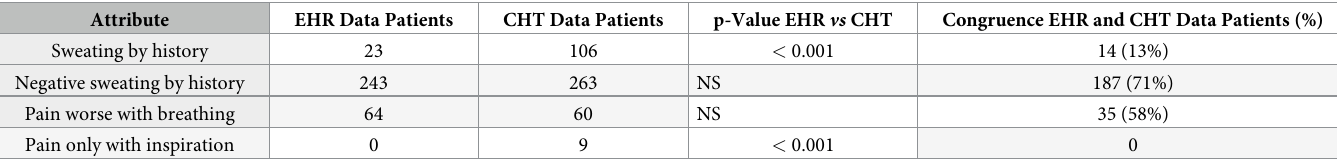
EHR data was missing for a significant proportion of patients reporting sweating during CHT; and there was poor congruence between EHRs and CHTs for explicitly positive and negative findings for sweating with chest pain (Table 6). There was no significant difference between EHR and CHT data for the number of patients with no sweating. But the lack of congruence between EHRs and CHTs for absence of sweating was signif- icant at p < 0.001. The lack of congruence between EHR and CHT data for pain exacer- bated by respiration also was significant (p < 0.001). EHRs cited that some patients had pain with breathing and others had pain with inspiration. CLEOS asked patients with a pleuritic component of pain whether pain was exacerbated by breathing or caused by inspiration and absent during breath-holding. CHT data identified 9 patients with pain relieved by breath- holding. None of these patients was identified by EHR data. Nine patients cited in EHRs with pain during inspiration had a pleural component of pain in CHT data but indicated that breathing exacerbated pain that was not relieved by breath- holding. Table 6. Associated symptoms of sweating and pleuritic